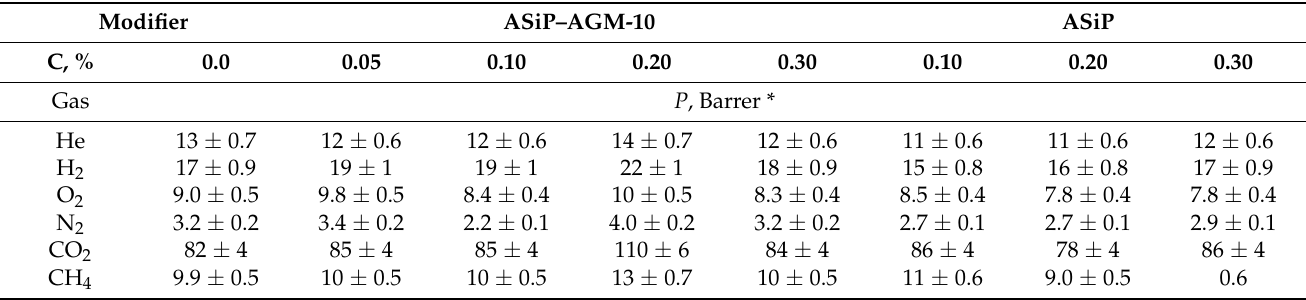
Table 1. Permeability coefficients ( P ).